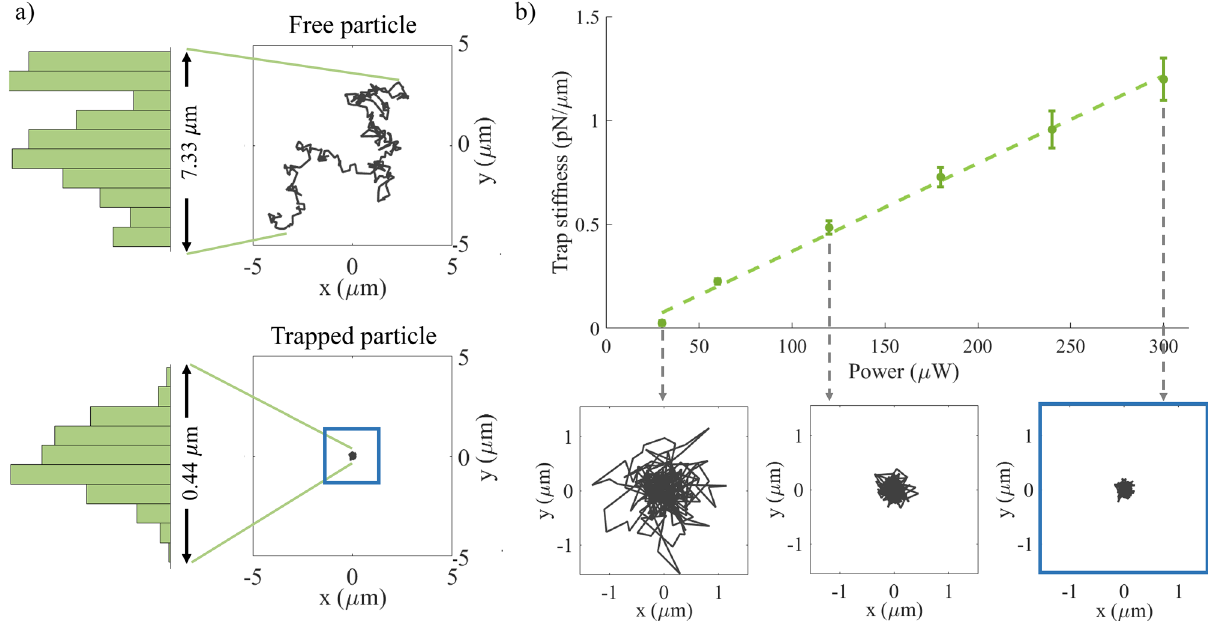
Figure 6. Optically trapping a 2 µ m particle with a vector flat-top beam. ( a ) Trajectory and probability density (in the y-direction) of a free particle and a particle trapped with a vector flat-top beam, monitored for 5 min. The free particle exhibits Brownian motion and moves over 7.33 µ m whereas the trapped particle’s movement is restricted to only 0.44 µ m . ( b ) Vector flat-top trap stiffness (in the x-direction) at different laser powers. The insets show the trajectory of a trapped particle at increasing powers of 30 µ W , 120 µ W and 300 µ W ,